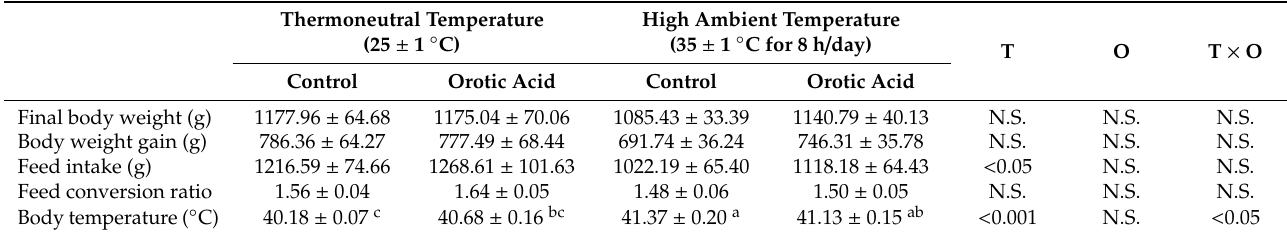
Table 1. E ff ects of a cyclic high ambient temperature and feeding orotic acid on the growth performance parameters of broiler chickens.